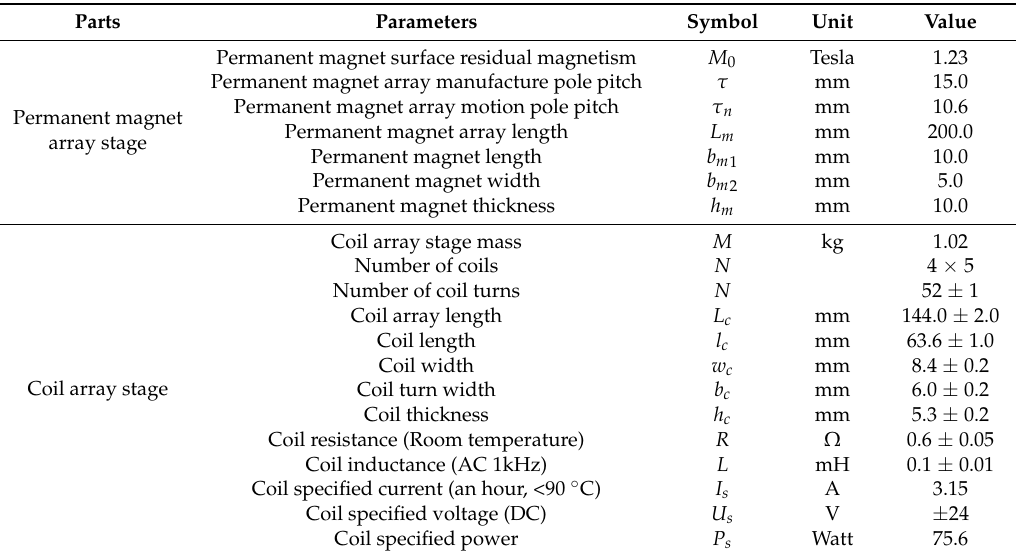
Figure 2. Configurations and parameters of MLPM (magnetically levitated planar motor) under investigation: ( a ) Halbach permanent magnet array; ( b ) coil array. Table 1. Related parameters and dimensions of MLPM (magnetically levitated planar motor) under investigation.